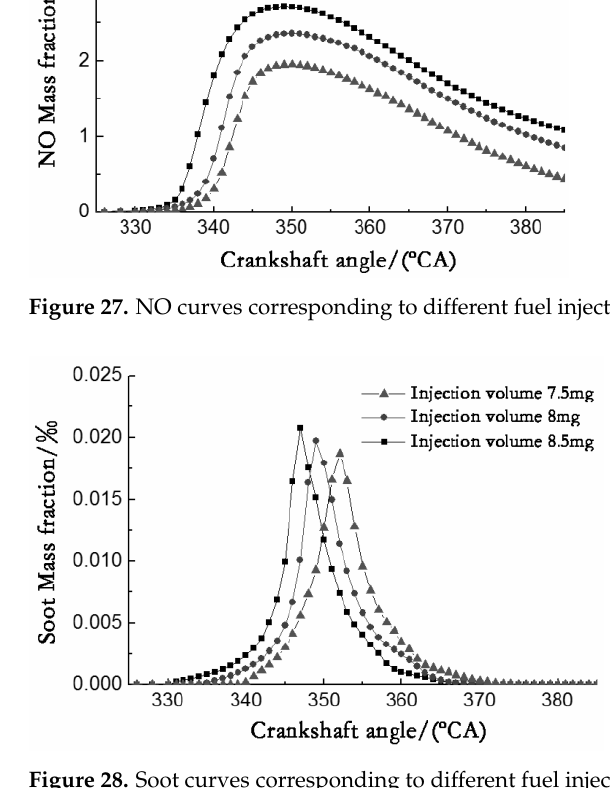
Figure 28. Soot curves corresponding to different fuel injection volumes.